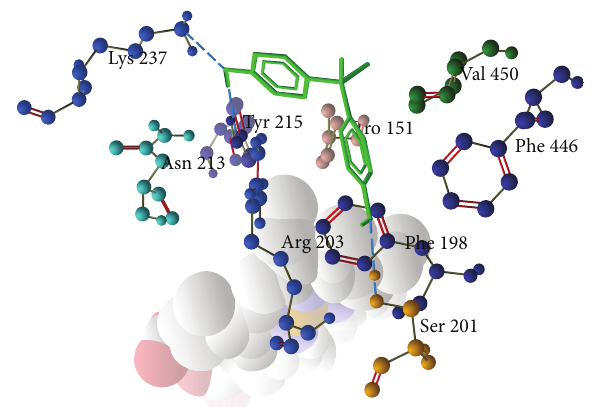
Figure 5: Hydrogen bond and Steric interaction of human catalase (PDB id-1QQW) with bisphenol A. Green color is bisphenol A and whole structure is of